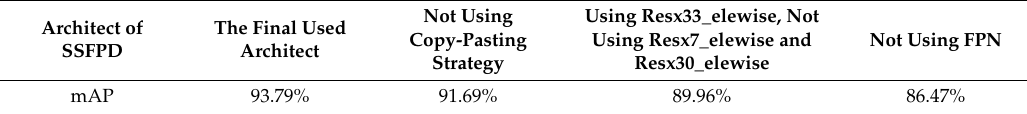
Table 5. Performance comparison of di ff erent design for